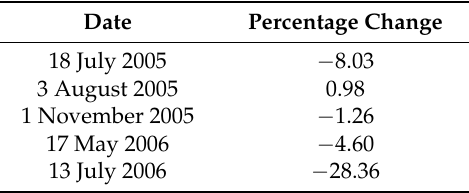
Table 1. Response of Centerra Gold share price to Kumtor protests over a five-day period following protest onset